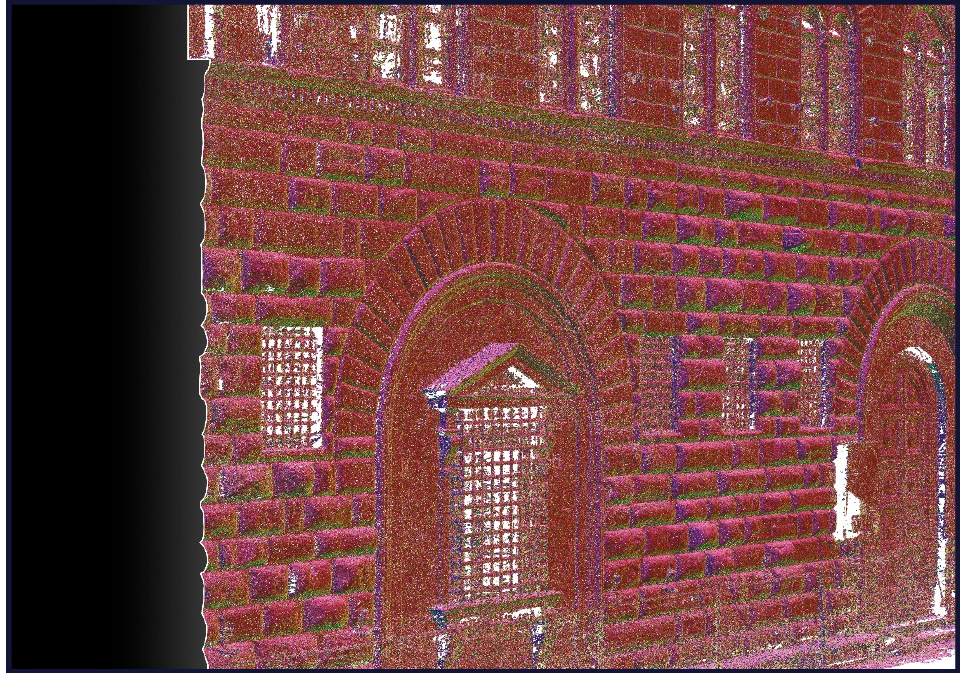
Figure 6. Portion of the point cloud from the facade of Via Cavour.